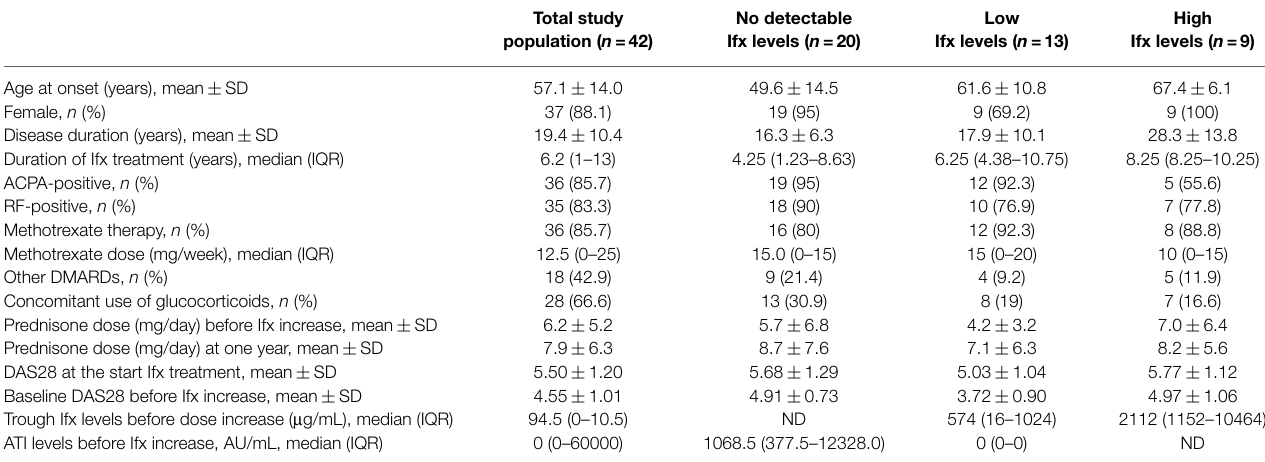
TABLE 1 | Demographic and clinical characteristics of patients .